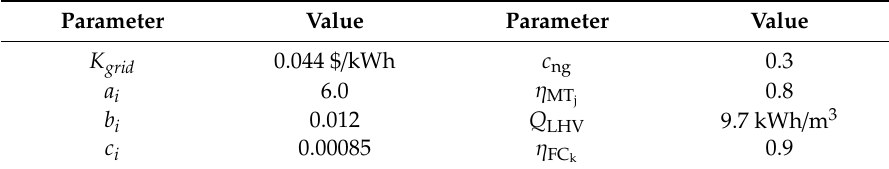
Table 2. Primary parameters of economic cost (ECC) models [33].